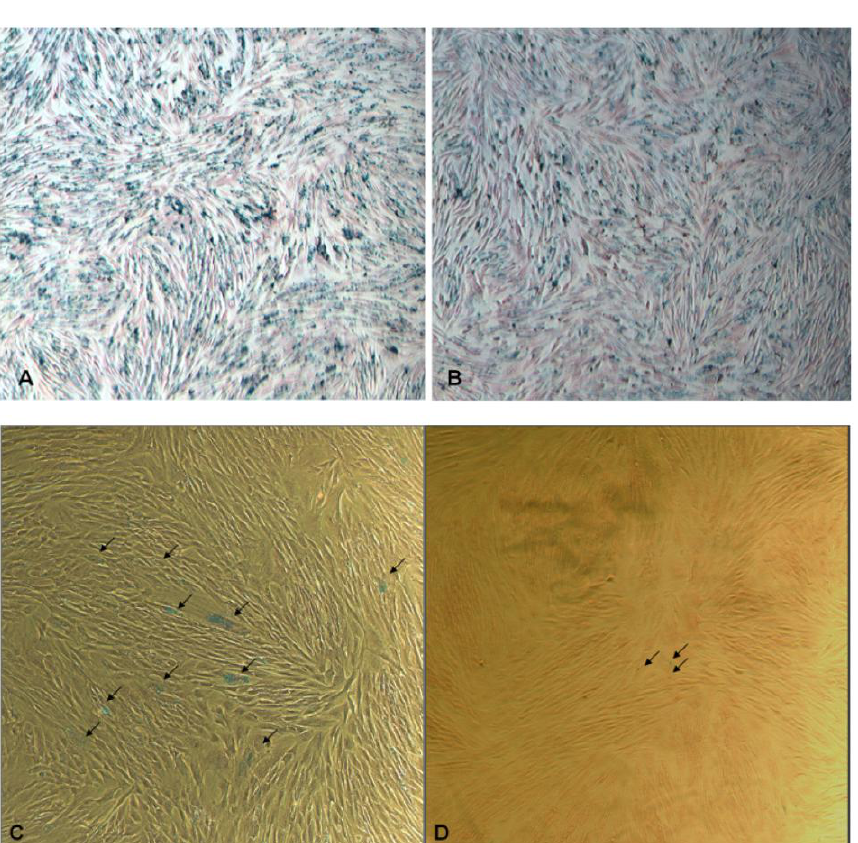
Figure 3. Optical microscopic images of (A) SPIO@SiO -labeled and (B) SPIO@PEG- 2 labeled mesenchymal stem cells (MSCs) post Prussian blue staining at day 0 (original magnification: ×20). The MSCs in (A) and (B) were extensively labeled with SPIO. The blueness values are ca. 14 for both figures. (C) SPIO@SiO -labeled MSCs after three 2 weeks (original magnification: ×40); there are multiple blue stained dots (arrows). (D) SPIO@PEG-labeled MSCs after three weeks (original magnification: ×40); it shows only trace amount of blue stained dots (arrows). The intensity of blueness for MSCs labeled with SPIO@SiO nanoparticles was 2.4 while that of MSCs labeled with 2 SPIO@PEG nanoparticles was